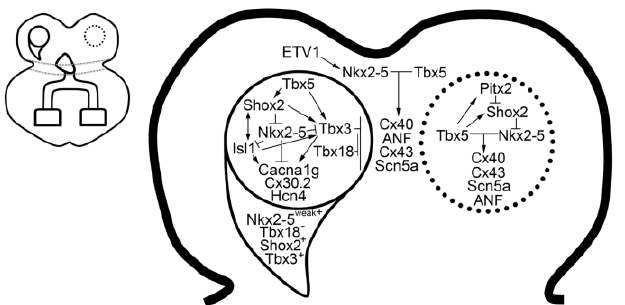
Figure 3. Sinus node gene regulatory network. The right-sided sinus node is partitioned into the head region (circle) and tail region (half crescent). The default left-sided sinus node gene regulatory network (dotted circle) is suppressed by Pitx2. Schematic overview of the cardiac conduction system, left panel; sinus node schematic, right panel (Reproduced with permission from [14]).